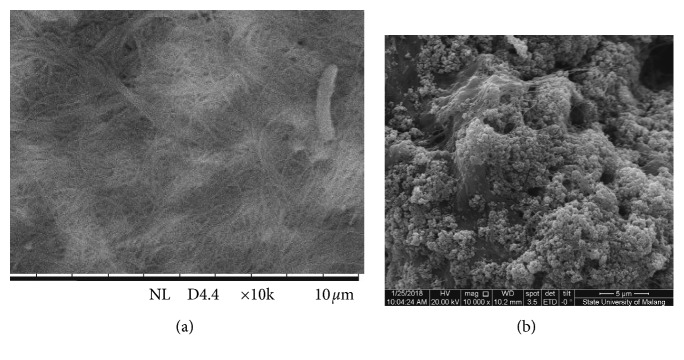
SEM images (mag: 10000x) of the sensor surface without (a) and with (b) addition of Fe3O4 nanoparticles.